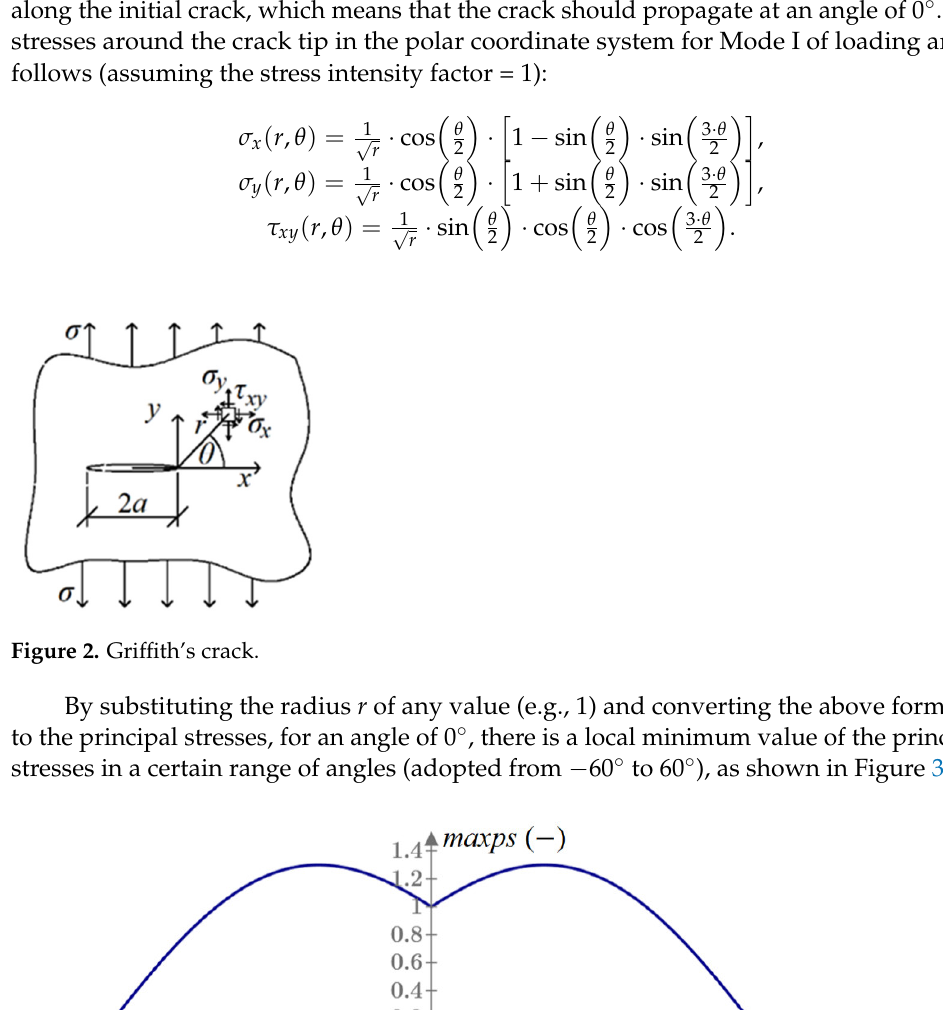
Figure 3. Maximum principal stresses around Griffith’s crack in Mode I.